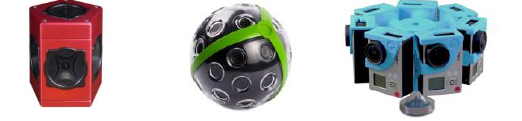
Figure 1. Immersive videography cameras (Ladybug®3, Panono camera and 360Heros built from seven GoPro